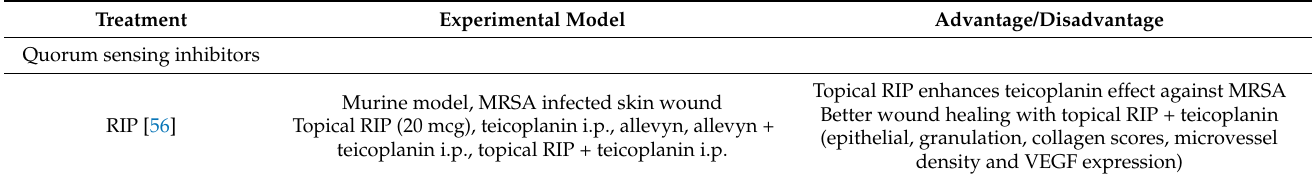
Table 1. Summary of new perspectives for the treatment of MRSA in psoriatic patients. Treatment Experimental Model Advantage/Disadvantage Quorum sensing